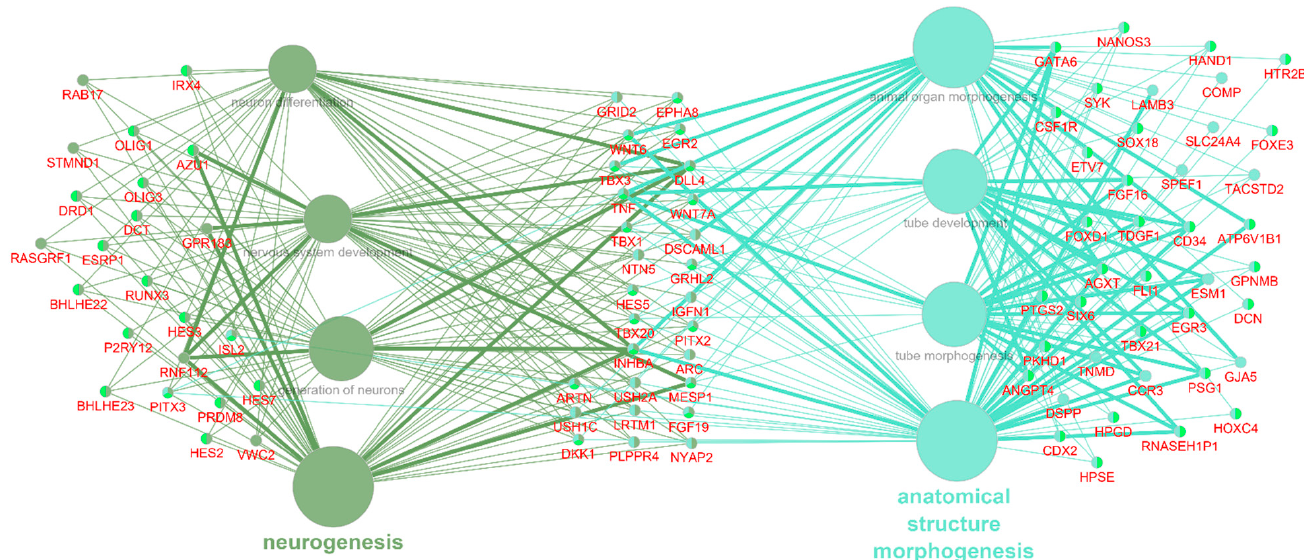
Figure 3. GO BP terms from groups I and II, significantly enriched with DEG NPC with DEG, associated with at least 2 terms. Genes in the middle are associated with terms from groups I and II. Genes on the left are associated with terms from group I, genes on the right are associated with terms from group II.